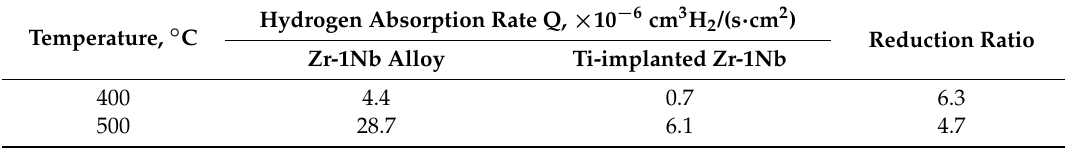
Table 2. Hydrogen absorption rate.